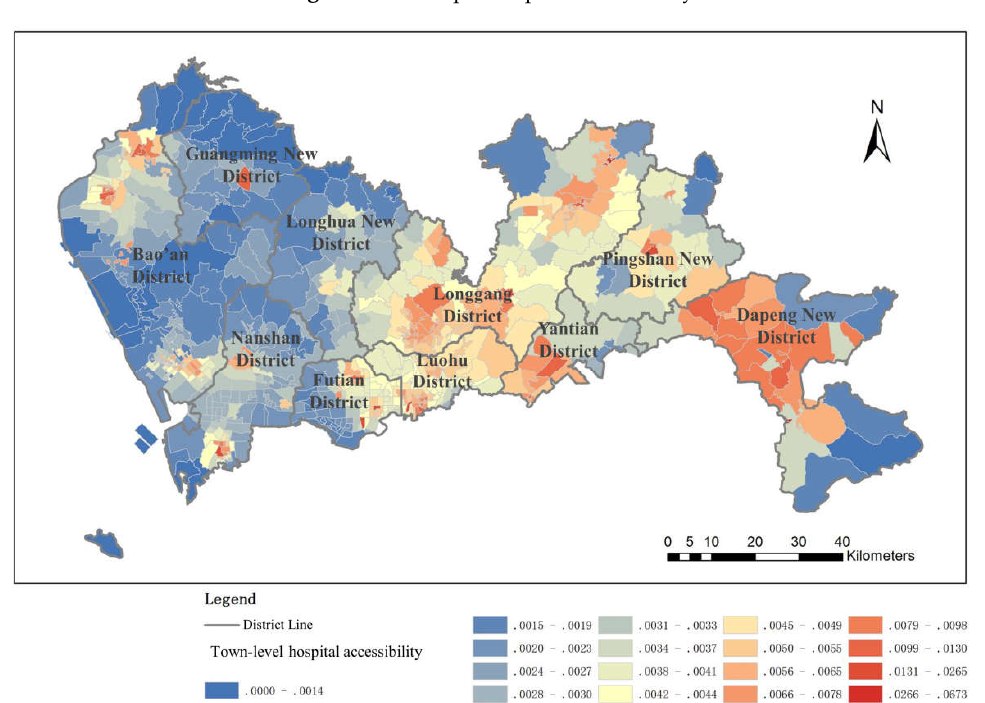
Figure 7. Town‐level hospital accessibility Figure 7. Town-level hospital